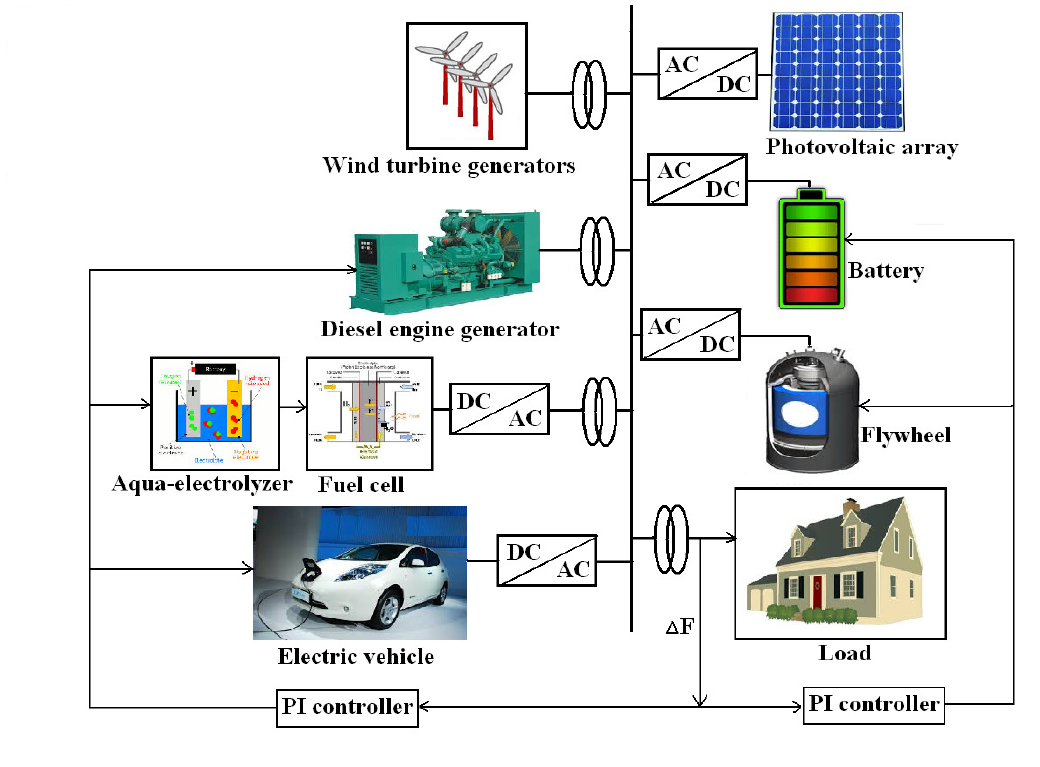
Figure 1. Single-line diagram of the hybrid power system. PI: proportional-integral